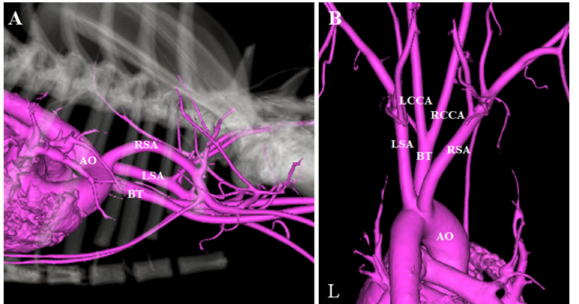
Figure 3. Three-dimensional reconstruction computed tomographic angiography images. ( A ) Right to left view. ( B ) Dorsoventral projection view. AO: aorta; BT: brachiocephalic trunk; L: left; LCCA: left common carotid artery; LSA: left subclavian artery; RCCA: right common carotid artery; RSA: right subclavian